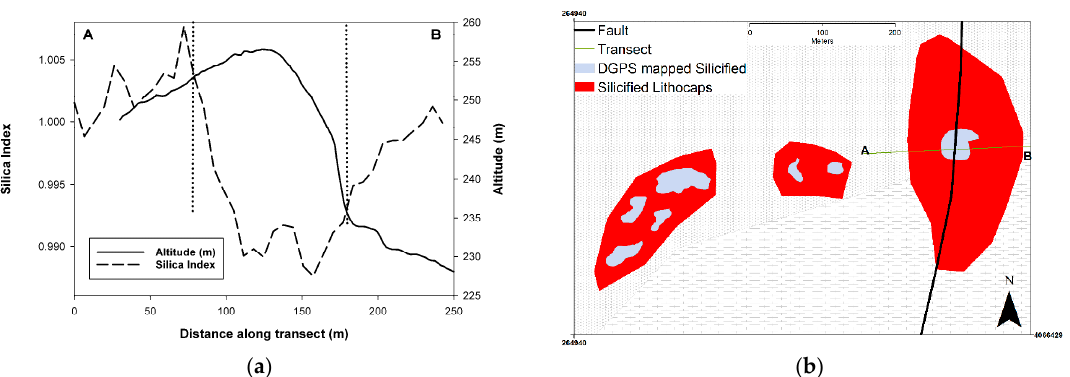
Figure 5. ( a ) Transect (A-B) showing topography and silica index. ( b ) Transect (A-B) west-to-east across silicified Lithocap at Kondaros. Dotted lines show limits of mineralized zone.